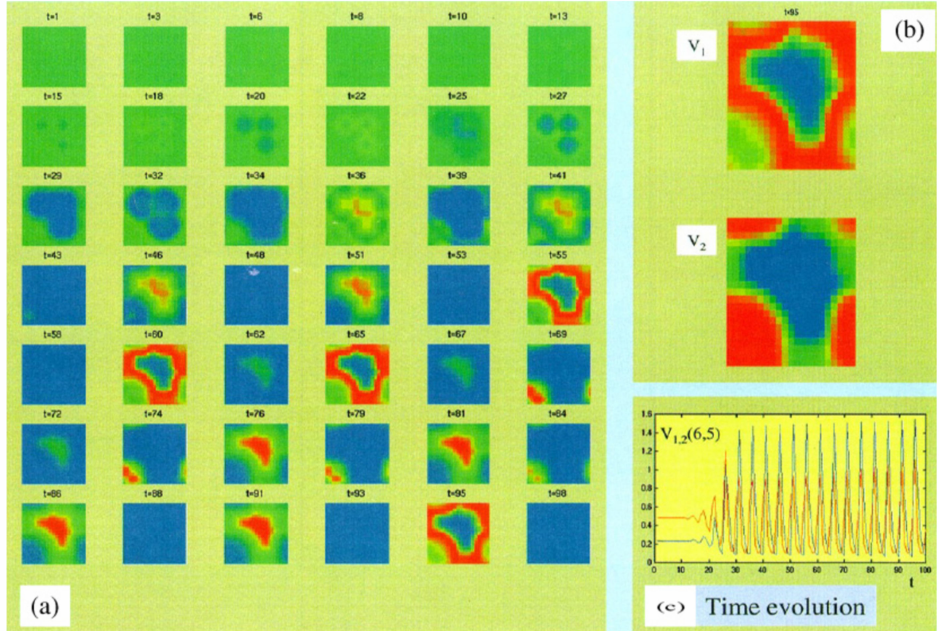
Figure 7. Dynamic patterns in Brussellator MCNN model (2). ( a ) 42-time evolution snapshots of the state variable, ( b ) a snapshot of the dynamic patterns at t = 100, ( c ) time evolution of the state variables in red and in